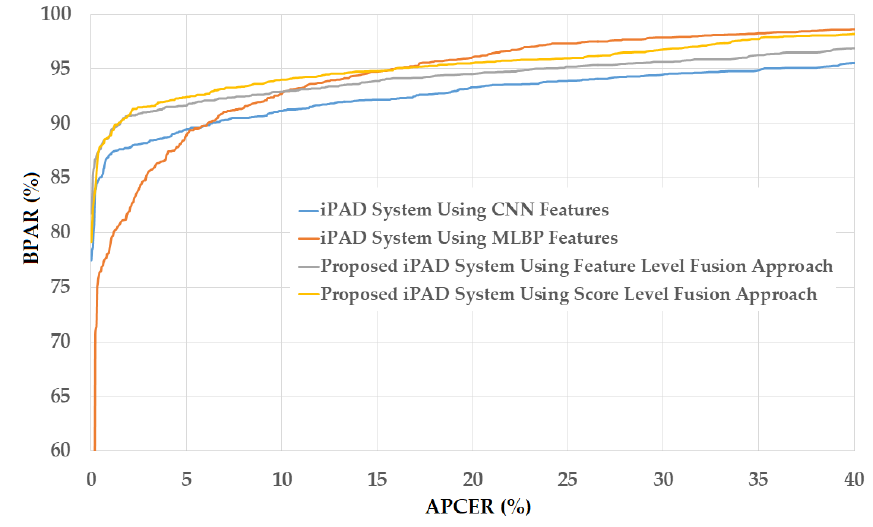
Figure 19. DET curves of iPAD systems based on use of CNN, MLBP, and hybrid image features (feature level fusion and score level fusion approach) using unknown data from a combination of ND2015 and Warsaw2017 datasets.